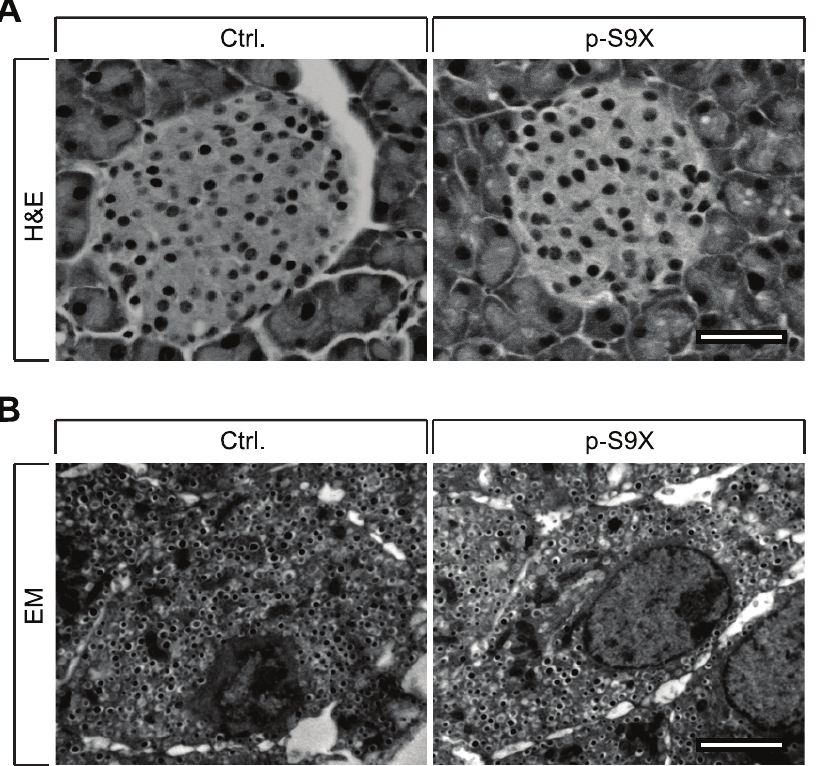
Figure 4. p-S9X mice exhibit similar islet architecture and b -cell ultrastructure as their control mice. ( A ) Histological sections stained with hematoxylin and eosin (H&E). Representative sections are shown for p-S9X and control islets. N=4 mice for each genotype. Scale bar=50 m m. ( B ) Transmission electron micrographs showing b -cells of p-S9X and control pancreas. Scale bars=2 m m.